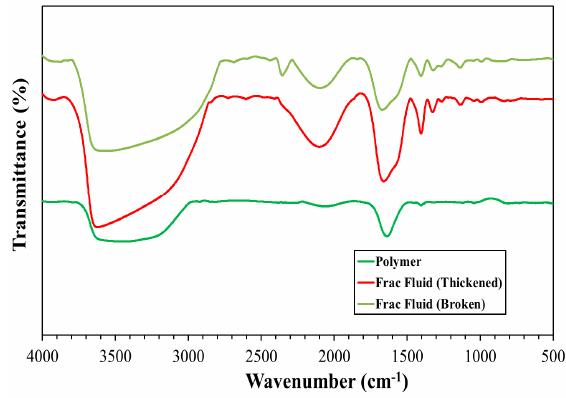
Figure 10. FTIR analysis of polymer in deionized water and developed fracturing fluid.